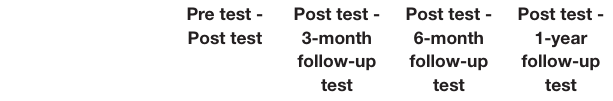
TABLE 7 | ANOVA analysis and effect sizes of near transfer tasks in Experiment 1. TABLE 8 | ANOVA analysis and effect sizes of far transfer arithmetic skills task in Experiment